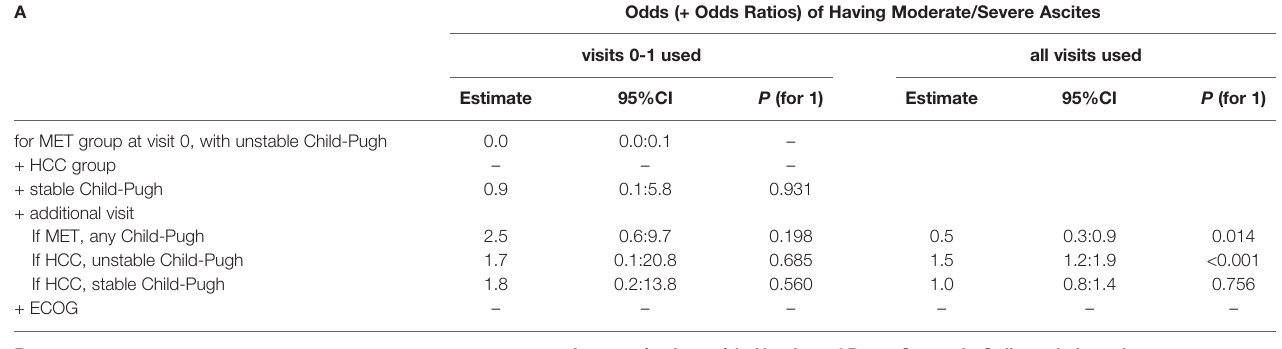
TABLE 3 | Longitudinal analysis of ascites and portosystemic collaterals formation.